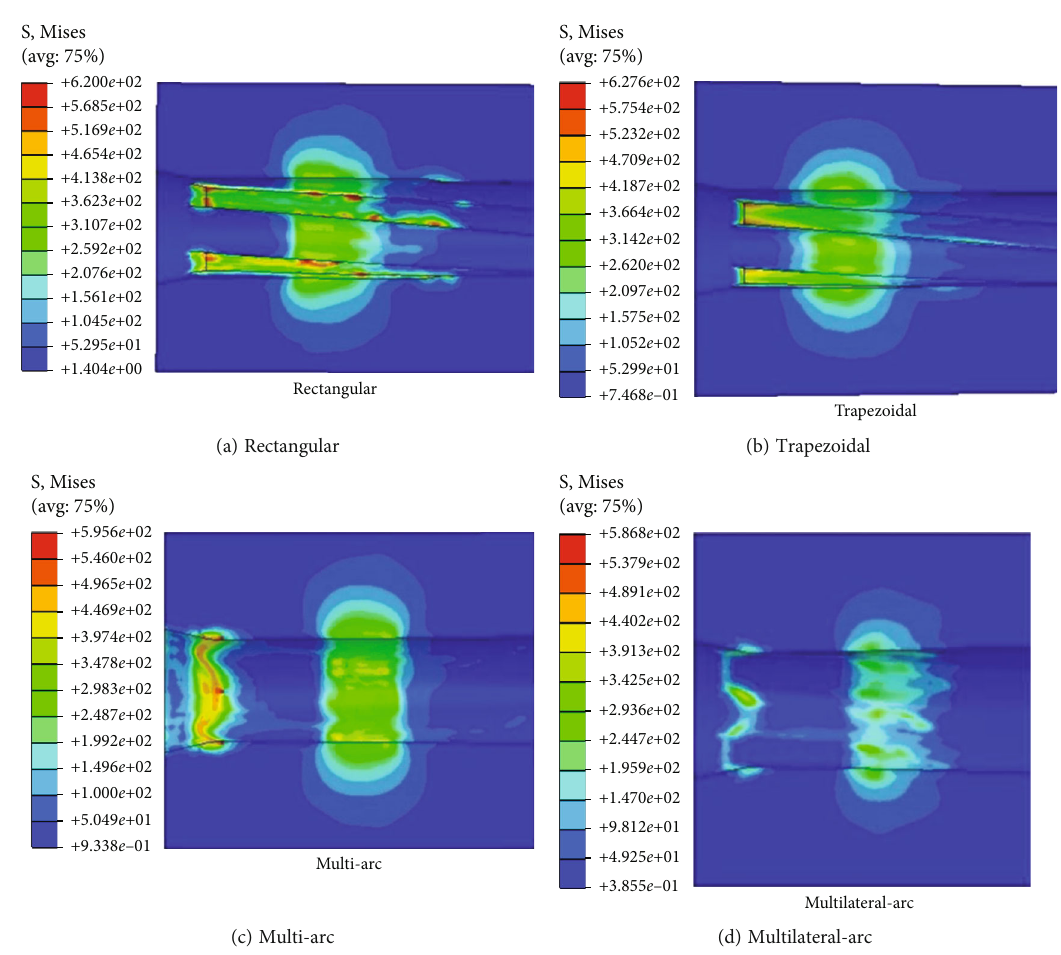
Figure 16: Nephograms of the barrel stress under the maximum chamber